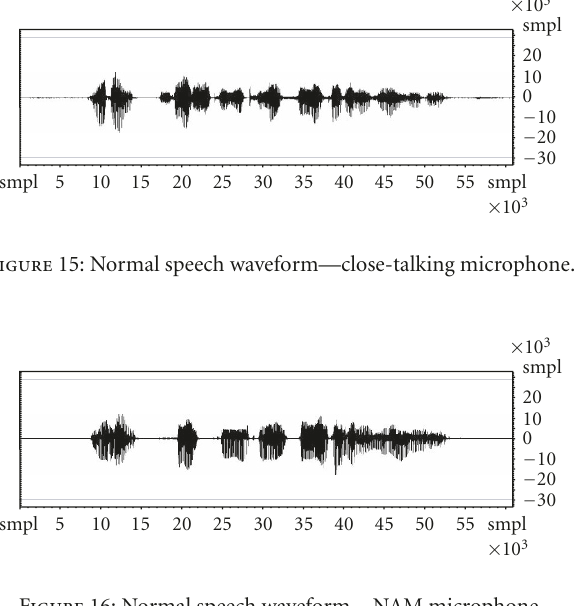
Figure 16: Normal speech waveform—NAM microphone.